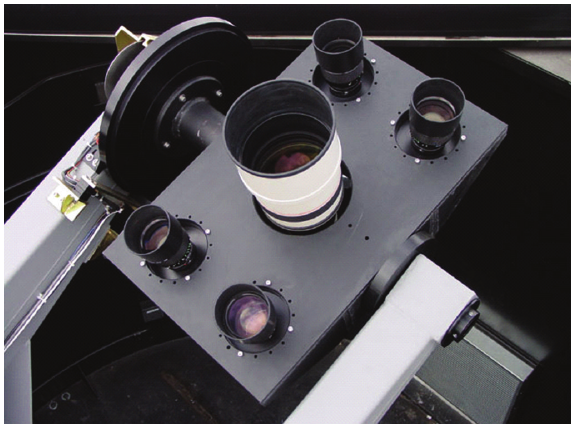
Figure 8: The RAPTOR array of wide-field lenses in LANL (U.S.), adapted from